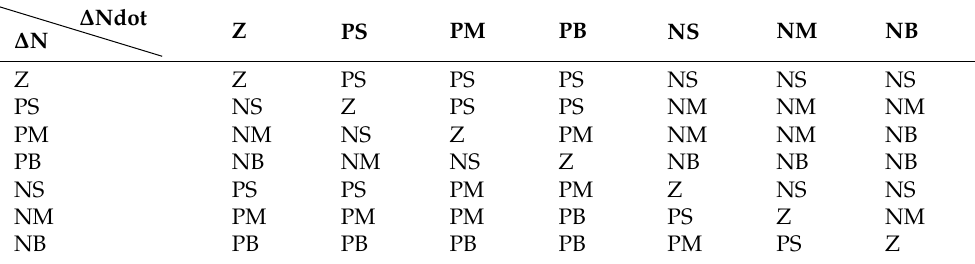
Table 3. Fuzzy rules to determine fuel flow changes (FMF) for the